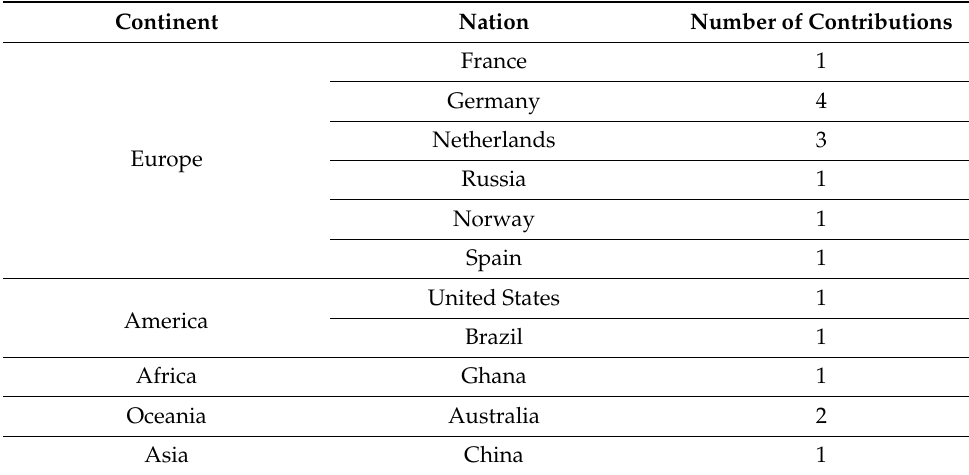
Table 2. Geographical areas of the studies under review.